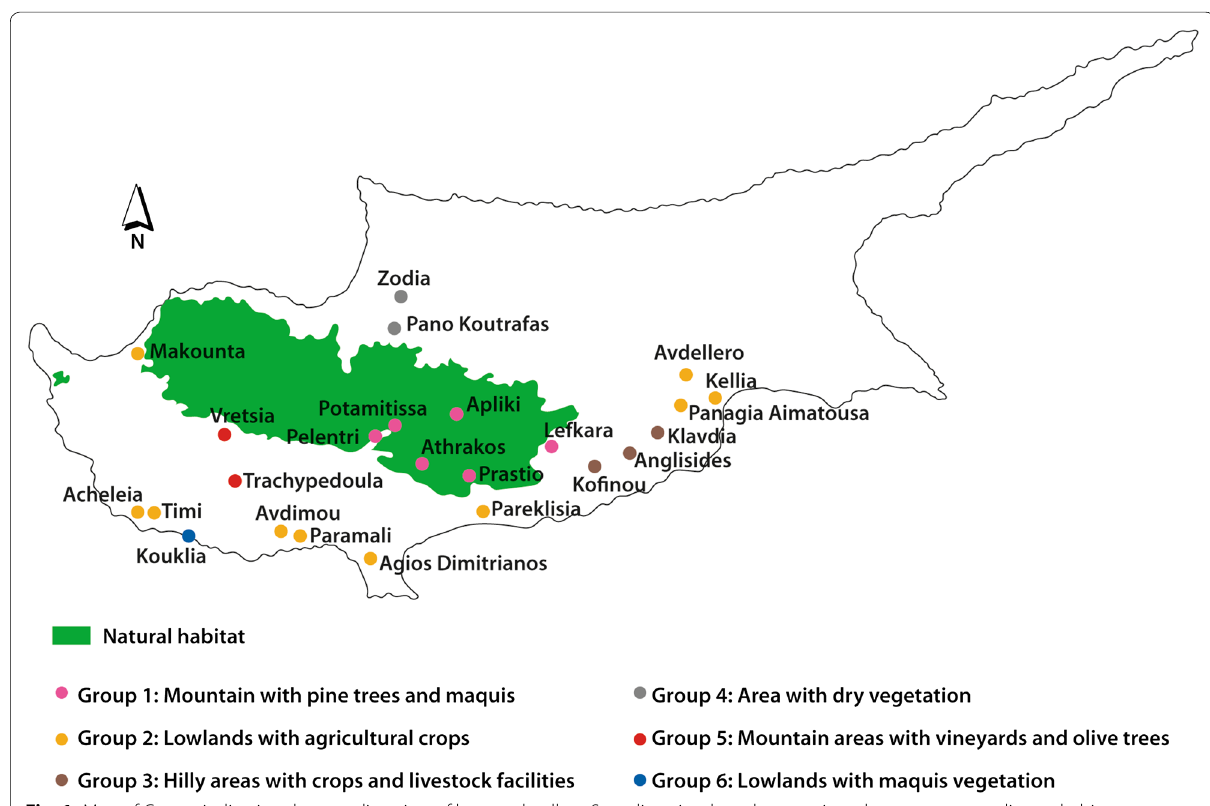
Fig. 1 Map of Cyprus indicating the sampling sites of barn owl pellets. Sampling sites have been assigned to groups according to habitat type